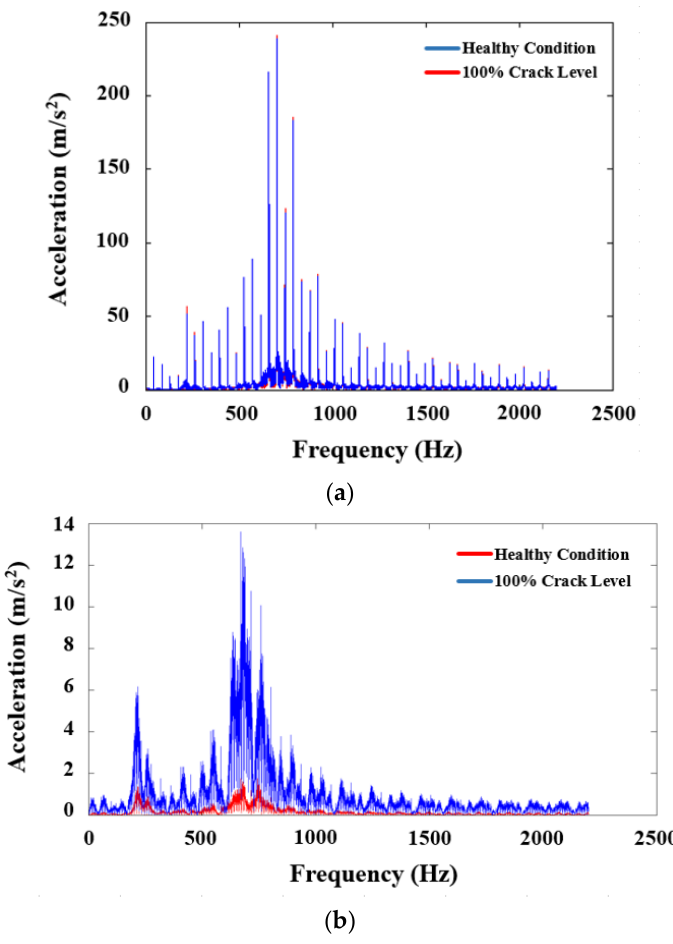
Figure 21. The frequency spectrum of vibration responses: ( a ) original signal; ( b ) residual signal.